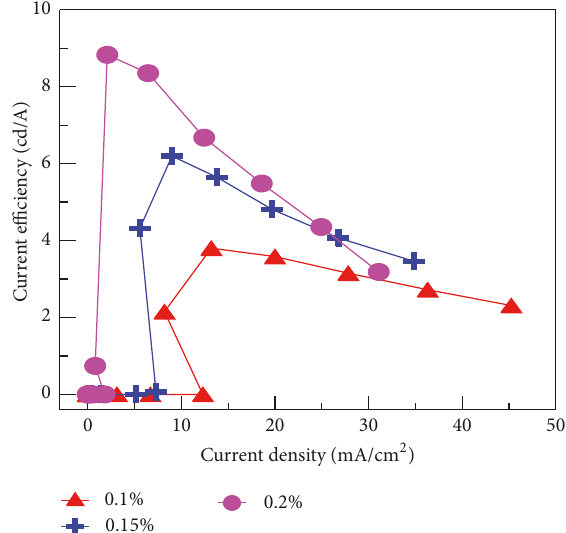
Figure 9: Current efficiency characteristics as a function of the current